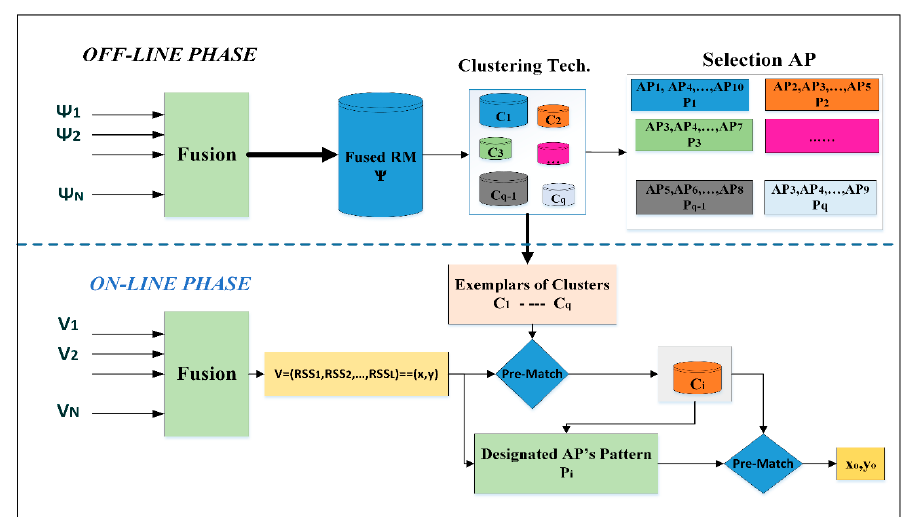
Figure 8. The block diagram of proposed system.